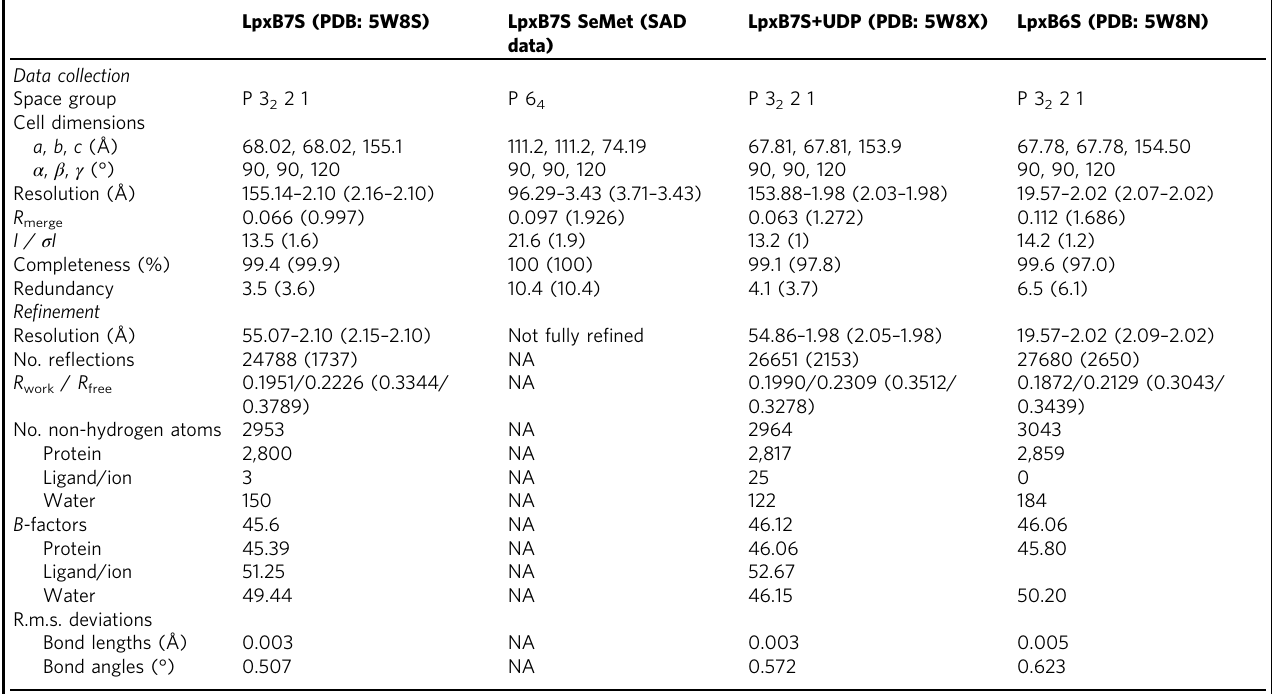
Table 1 Diffraction and re fi nement